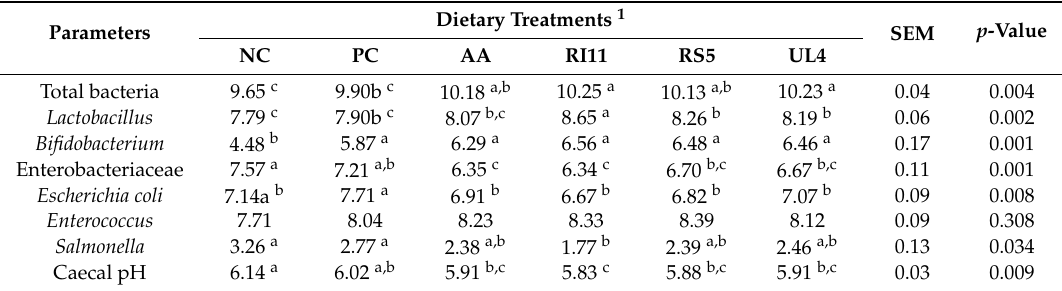
Table 7. Caecum microbial population (log 10 CFU / g) and pH in broiler chickens fed di ff erent postbiotics under heat